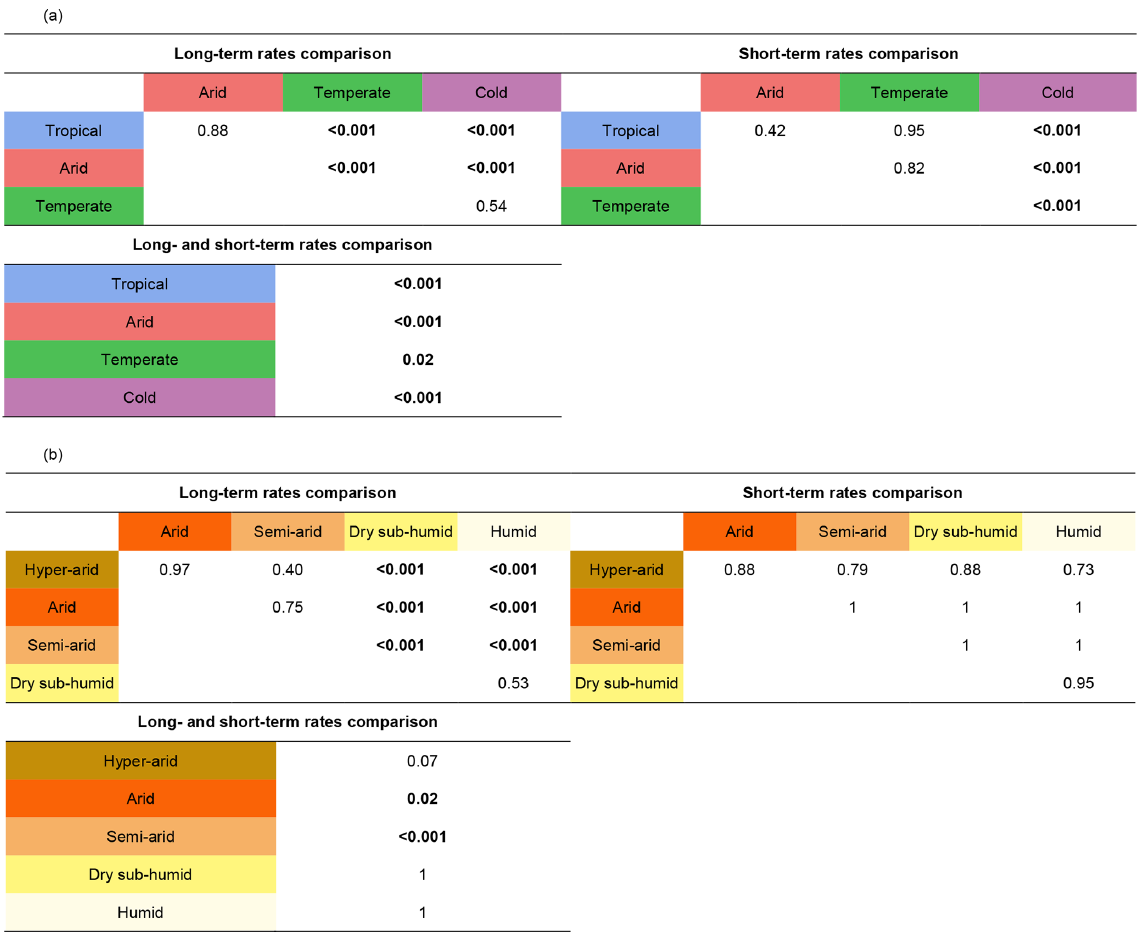
Table 1. The p values of Kruskal–Wallis tests comparing long-term ( n = 3074) and short-term ( n = 1521) erosion rates between climate zones of Köppen–Geiger climate classification (a) and Aridity Index classification (b) and between long- and short-term erosion rates of each climate zone. Bold numbers indicate significant p values ( < 0 . 05). The number of data points for each climate zone is listed in Fig.